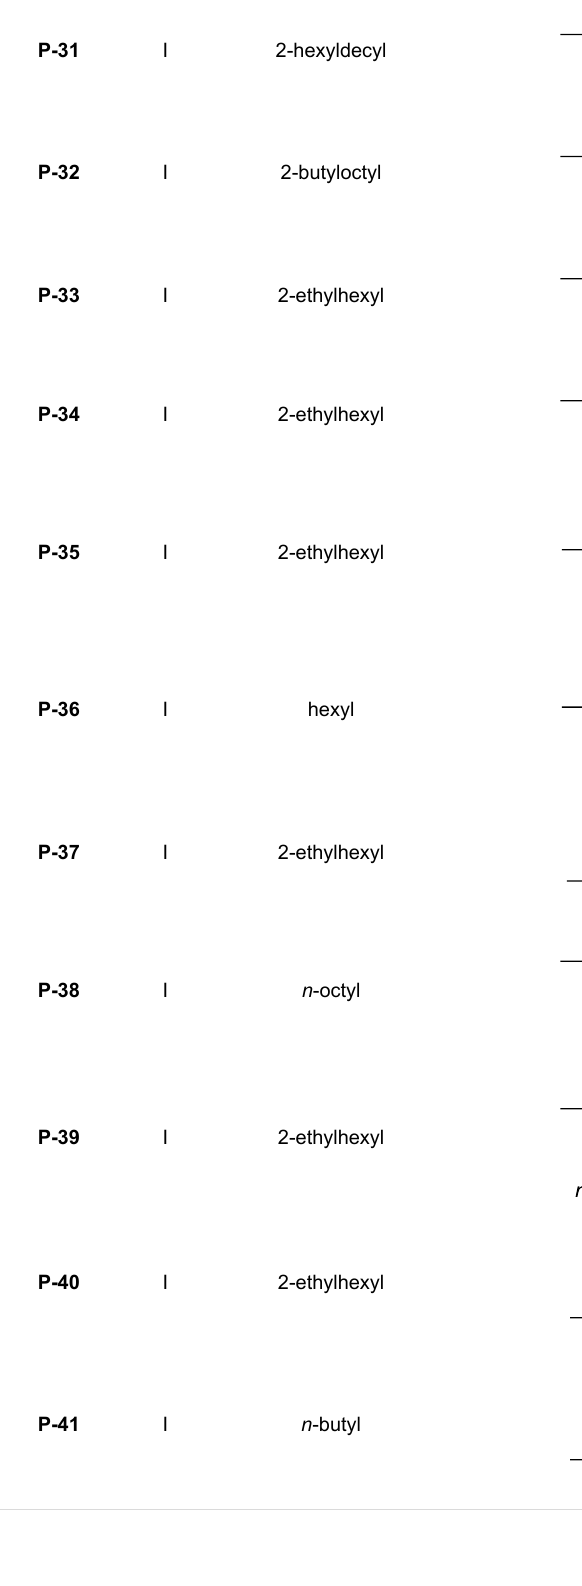
Table 5: Structure of thienyl-substituted DPP polymers used in photovoltaic devices. (continued)